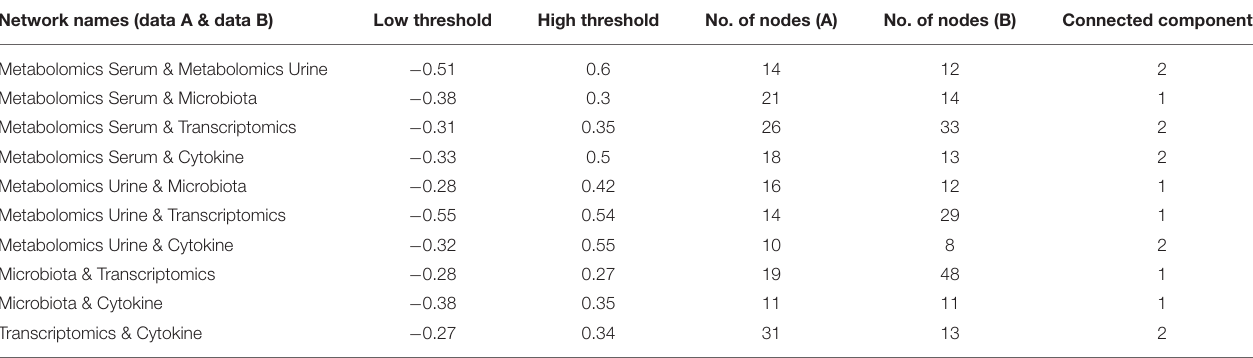
TABLE 2 | The 10 individual correlation networks. Network names (data A & data B)